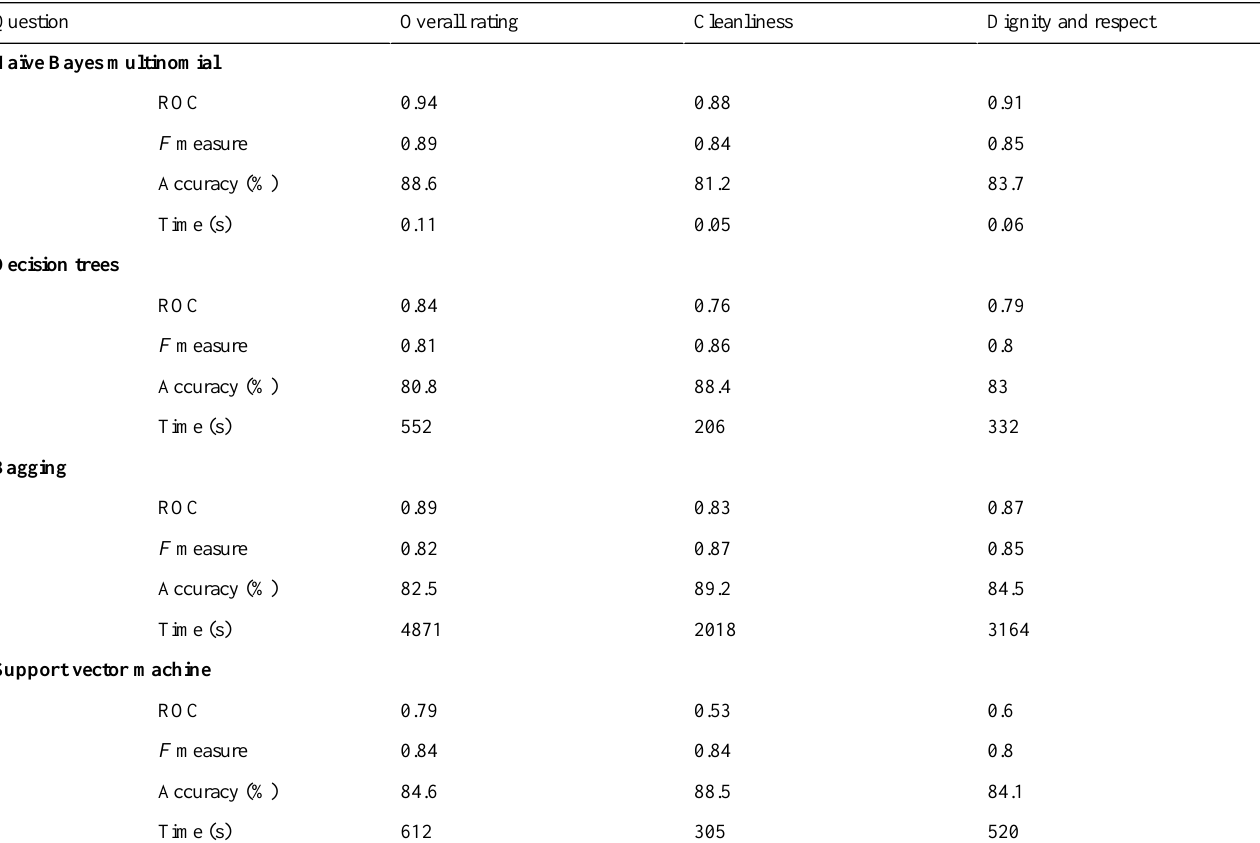
Table 1. Accuracy of different approaches to machine learning.